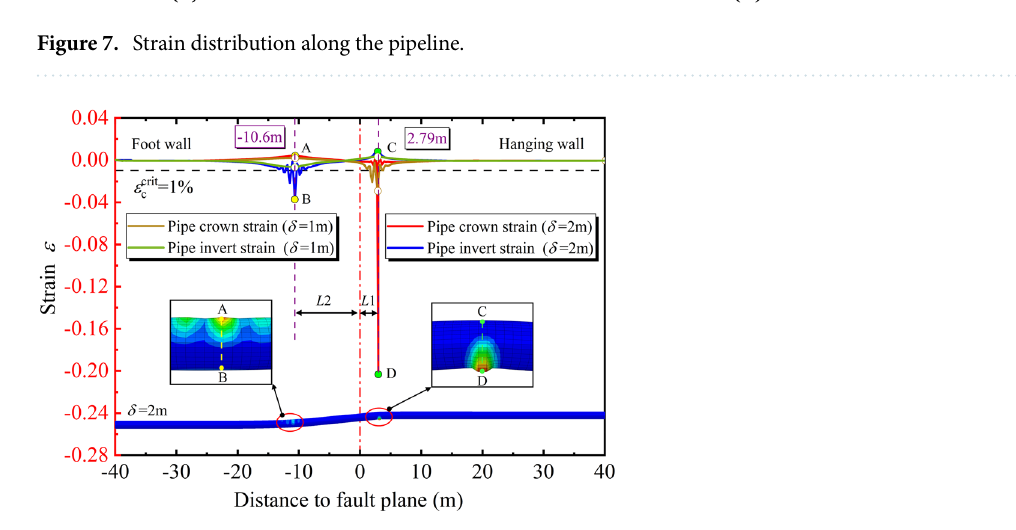
Figure 8. Pipe strain distributions along the pipeline under oblique-reverse displacement ( β = 90°, ψ = 60°, h = 1.2 m, t = 22 mm, D = 1.219 m, P = 12